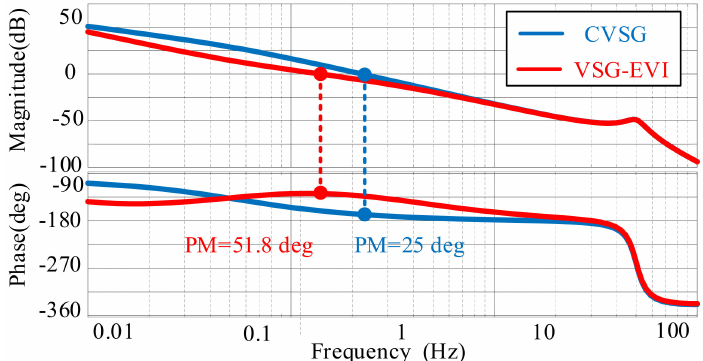
Figure 11. The Bode diagrams of the traditional VSG and